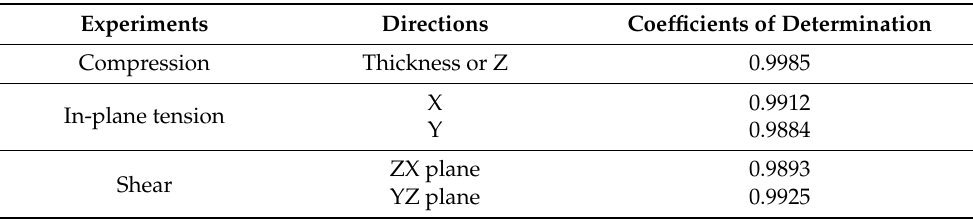
Table 2. Coefficients of determination of the 3-D numerical models of a carbon paper GDL for the correspondingly mechanical